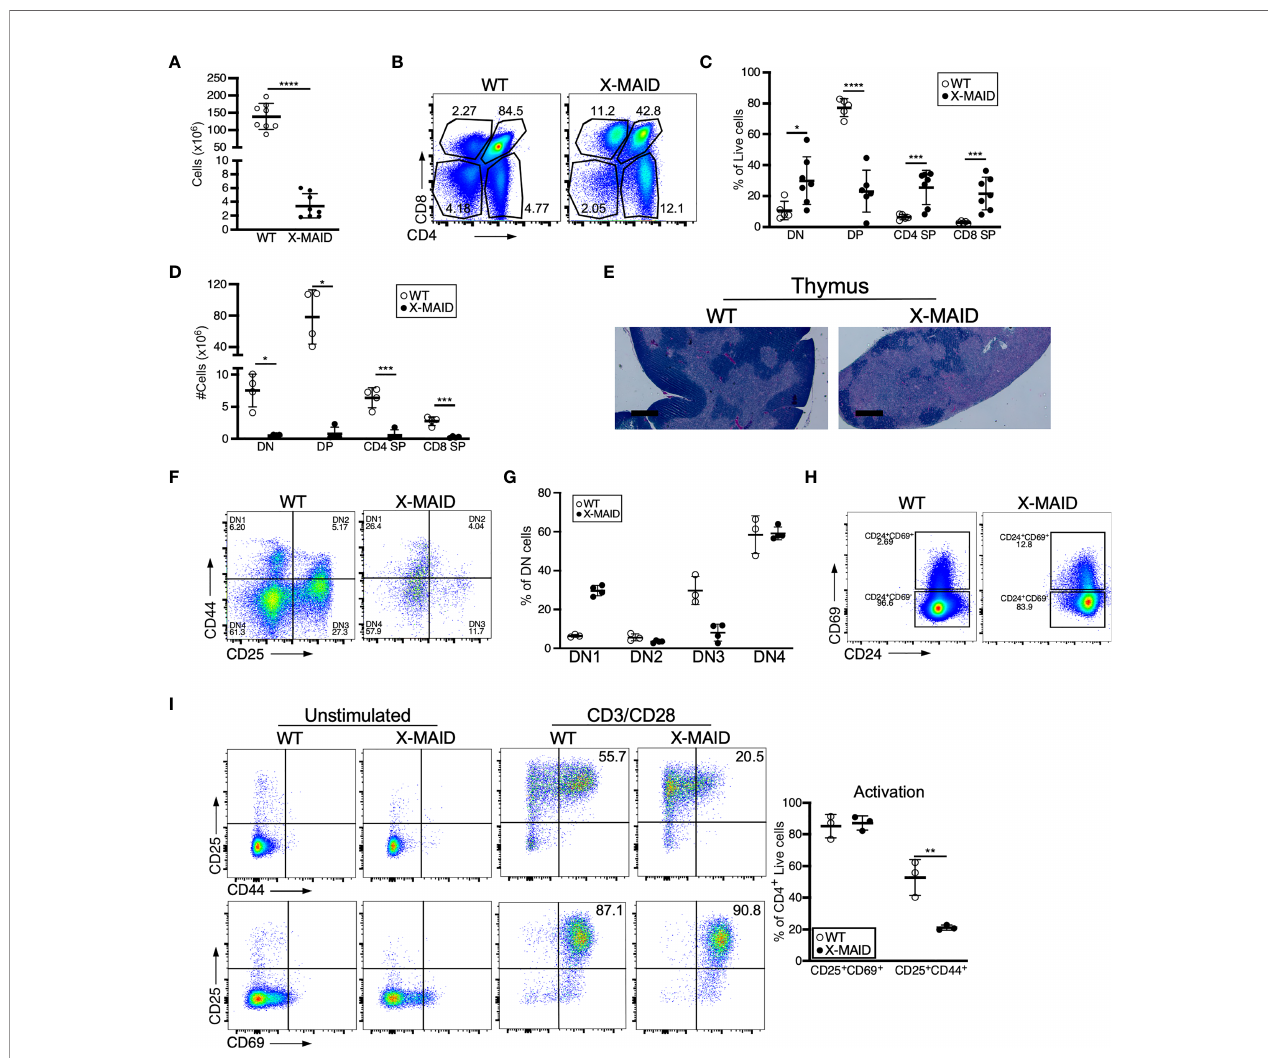
FIGURE 3 | Thymocyte numbers are reduced in X-MAID mice, but development and activation are grossly normal. Thymi from 3-4 week-old WT or X-MAID male mice were harvested and single cell suspensions were generated. (A) Total thymocyte number (B) Representative fl ow plots of thymocyte populations, gated on live single cells. Proportions (C) and absolute numbers (D) of thymocyte subsets were quanti fi ed, with each point representing an individual mouse. (E) H&E staining of the thymi from WT and X-MAID mice (representative of 4 mice for each genotype). Scale bars = 400 m m. (F) Representative fl ow plots of thymocytes prepared as in A-C stained with CD44 and CD25 and gated on the CD4 – CD8 – (DN) live population. (G) The proportion of each DN population (DN1-DN4) is quanti fi ed with each point representing an individual mouse. (H) Representative fl ow plots of thymocytes prepared as in A-C stained with CD69 and CD24 gated on CD4 + CD8 + live population. (I) CD4 SP Thymocytes from WT or X-MAID male mice were left unstimulated or stimulated overnight with CD3/CD28 and stained for CD25, CD69, and CD44. Representative plots are gated on CD4 SP live single cells (left) and the proportion of activated cells was quanti fi ed (right). Representative of 3 independent experiments. Data in (A, C, D, G, I) represent means ± StDev. Statistics were calculated using a Student ’ s t test, * p< 0.05, **p < 0.01, ***p < 0.005, ****p <